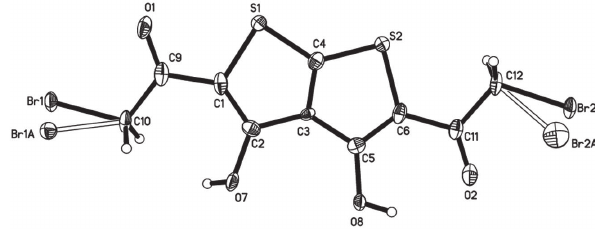
Table 1: Data collection and